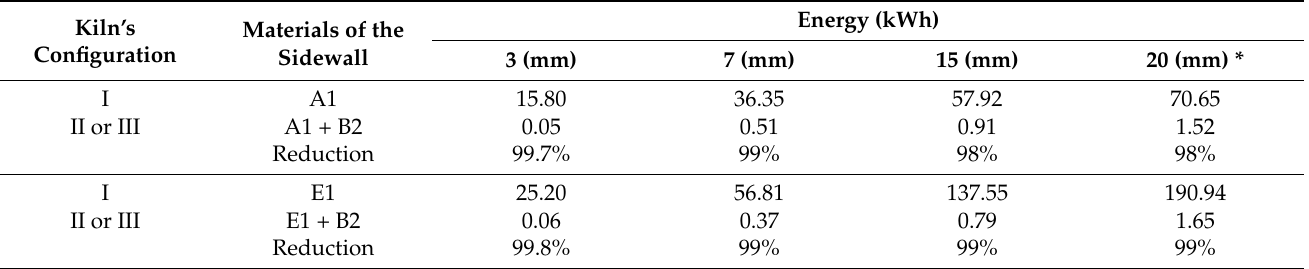
Table 7. Reduction of heat loss from sidewalls A1 + B2 or E1 + B2 (configuration II or III) compared to sidewalls A1 or E1 (configuration I).